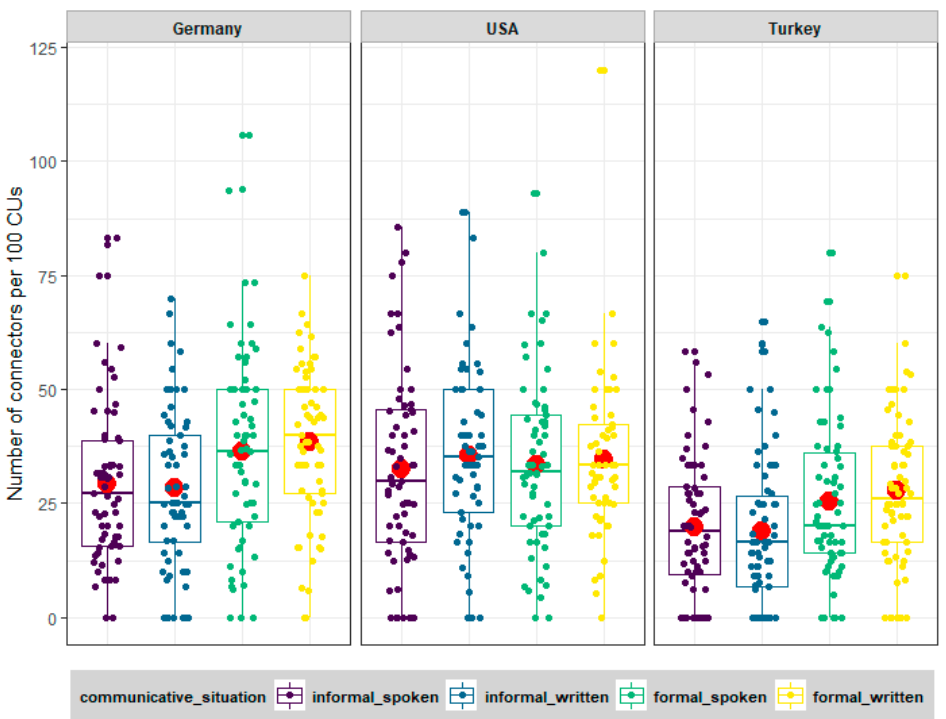
Figure 4. Box plots representing connectors use per 100 CUs with the focus on register and mode.